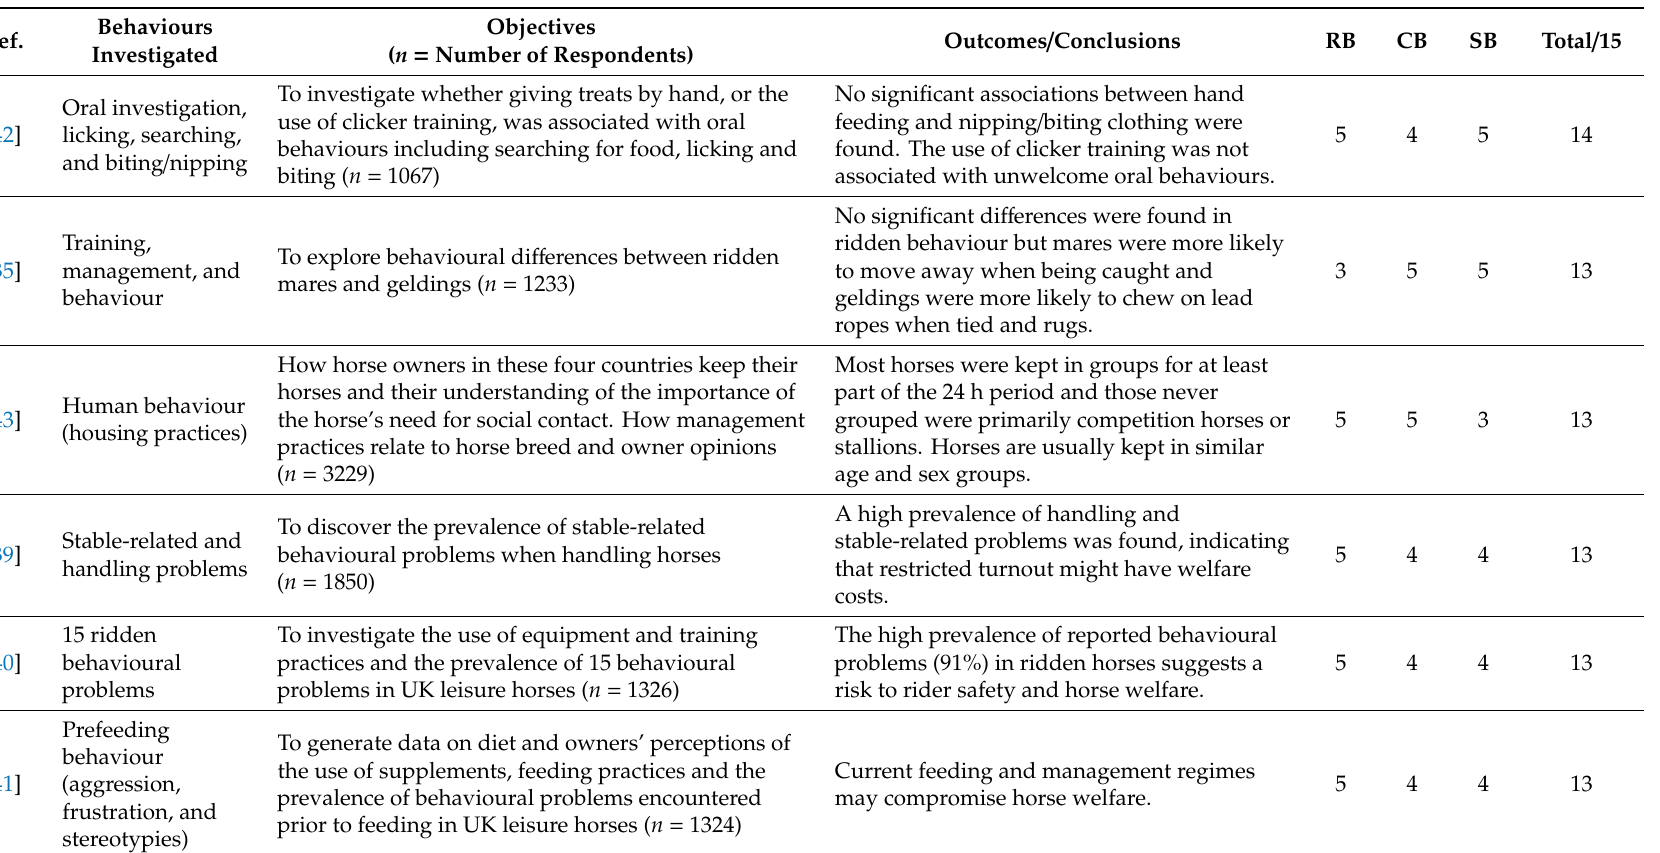
Table 3. Included reviews (Ref.) characteristics and reliability assessment [(recall bias (RB), confirmation bias (CB), and sampling bias (SB) with total reliability score (Total)] of studies using online surveys of > 1000 participants to quantify horse behaviour.